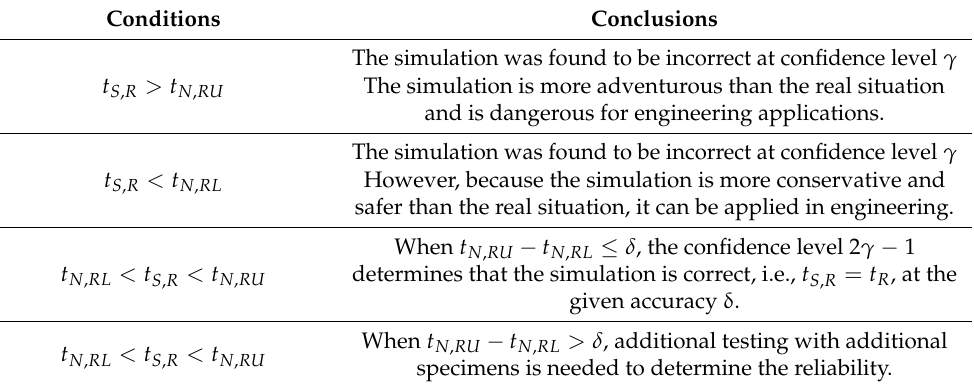
Table 1. Life reliability simulation test